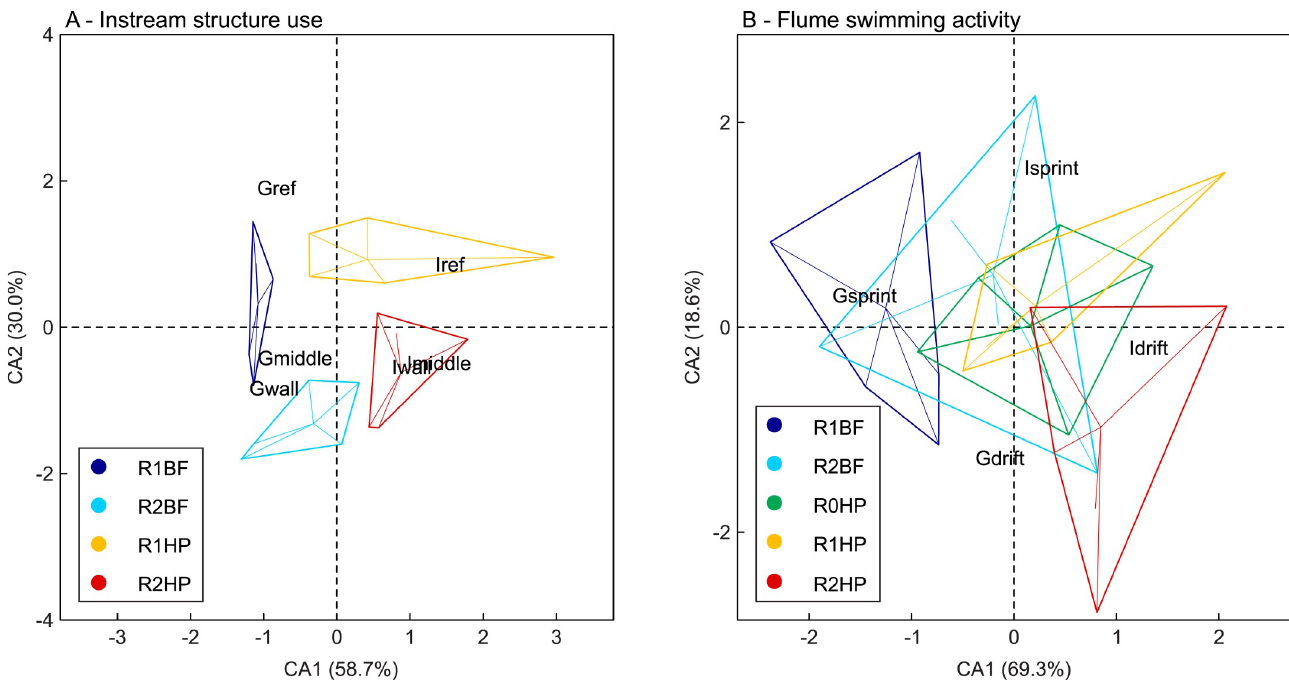
Fig 5. Correspondence analysis (CA) biplots for the instream structure use (A) and swimming activity in the flume (B). The biplots illustrate the spatial distribution of behaviour according to each flow event. The axes labels indicate the proportion (%) attributed to the spatial distribution of the events. R1BF and R2BF–Base-flow event in the presence of solid triangular pyramids and v-shaped structures respectively; R0HP, R1HP and R2HP–Hydropeaking event in the absence of structures, presence of solid triangular pyramids and presence of v-shaped structures respectively.